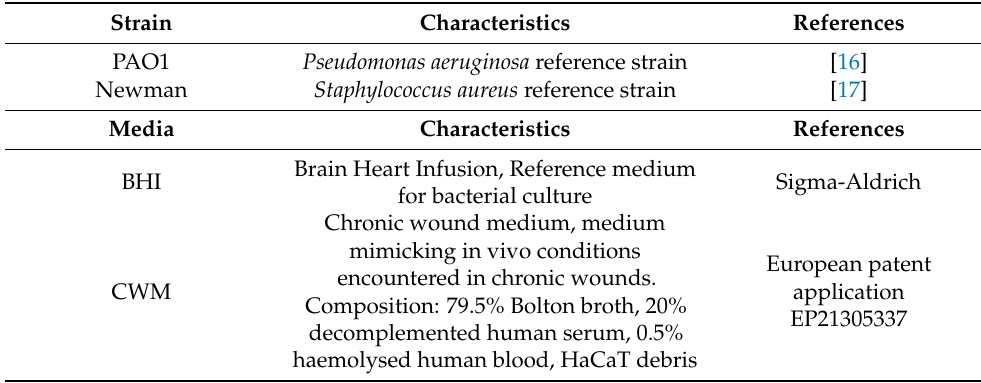
Table 1. Bacterial strains and media used in the study.